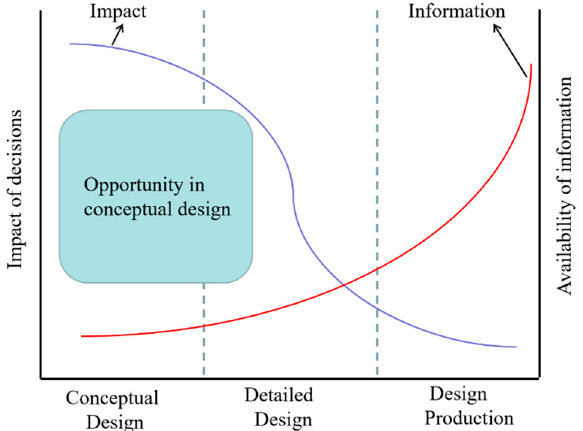
Figure 1. Opportunity in conceptual design.